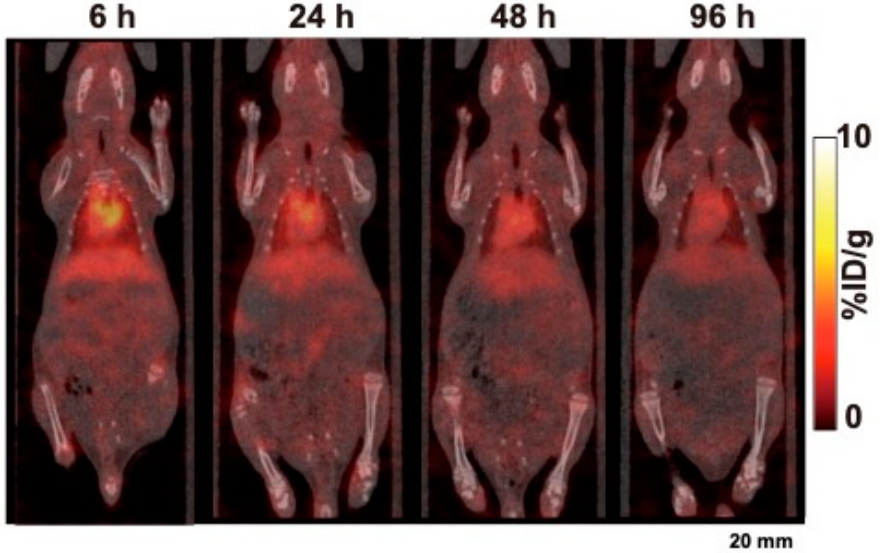
Figure 4. Temporal SPECT/CT imaging of 111 In-labeled anti-CD73 antibody 067-213 in a healthy rat. Representative SPECT/CT images at 6, 24, 48, and 96 h after intravenous injection (2.59 MBq).